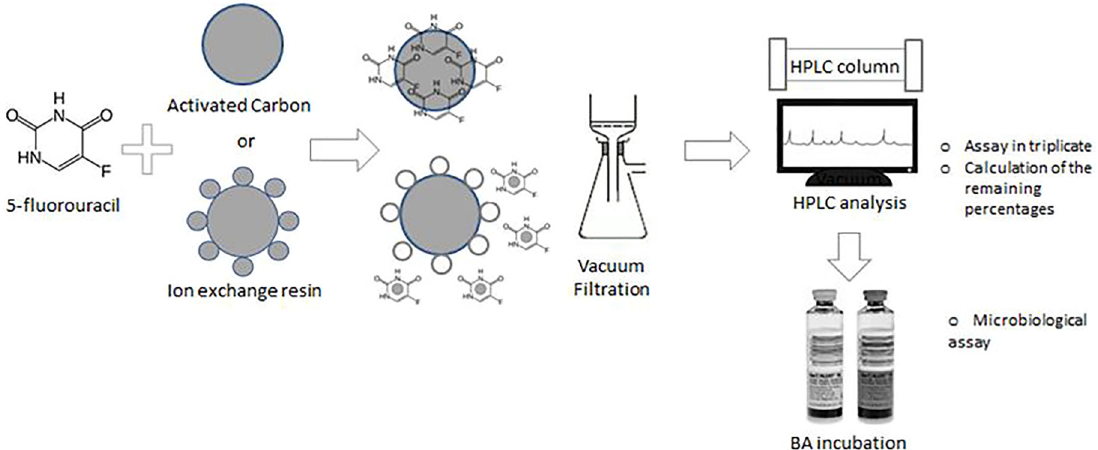
Figure 1: Summary of the method used for 5FU AC or IER